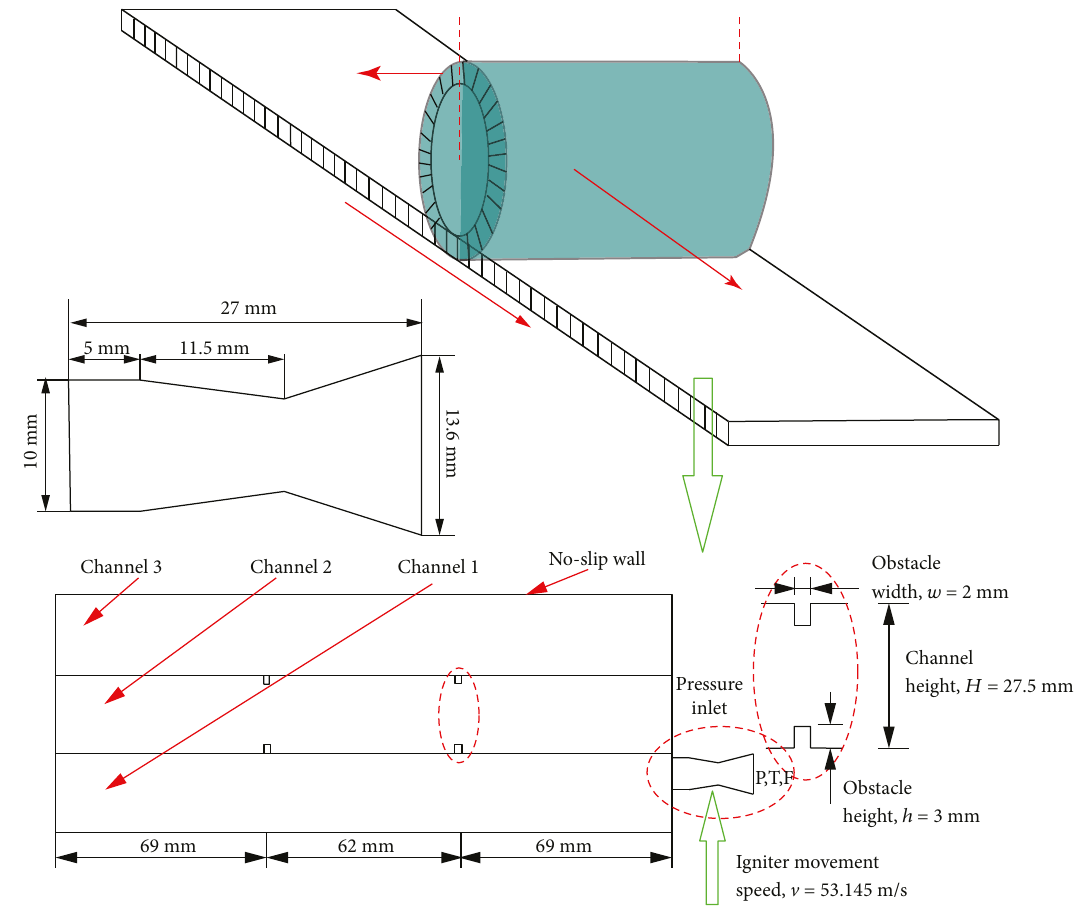
Figure 11: The simpli fi ed model of WRC. Table 6: Operating conditions used in